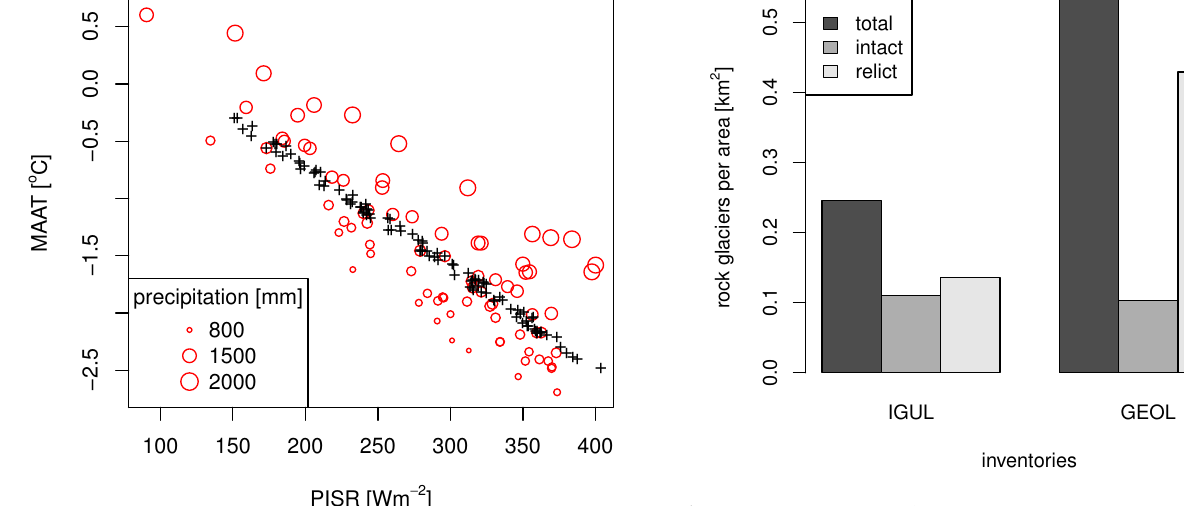
Fig. 8. Spatial density of rock glacier occurrence in inventories with high (IGUL Tecino, Switzerland; mean PRECIP=1900 mm) and low (GEOL, Trentino, Italy; mean PRECIP=1072mm) precip- itation. The relevant area is calculated for areas above 2000 m of elevation excluding glaciered areas (data provided by Paul et al., 2009) and steep slopes (slope angle < 50 ◦